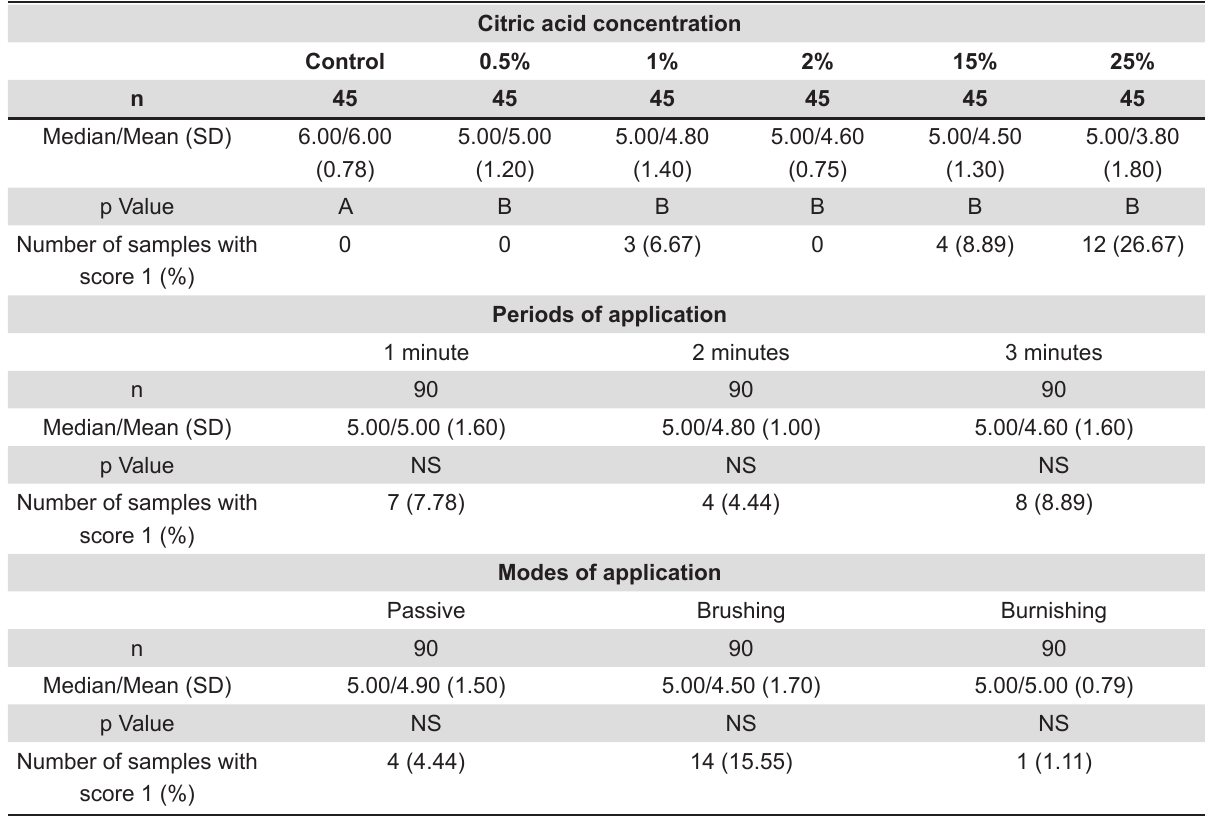
Table 1- Sample distribution for the citric acid concentrations, periods and modes of application